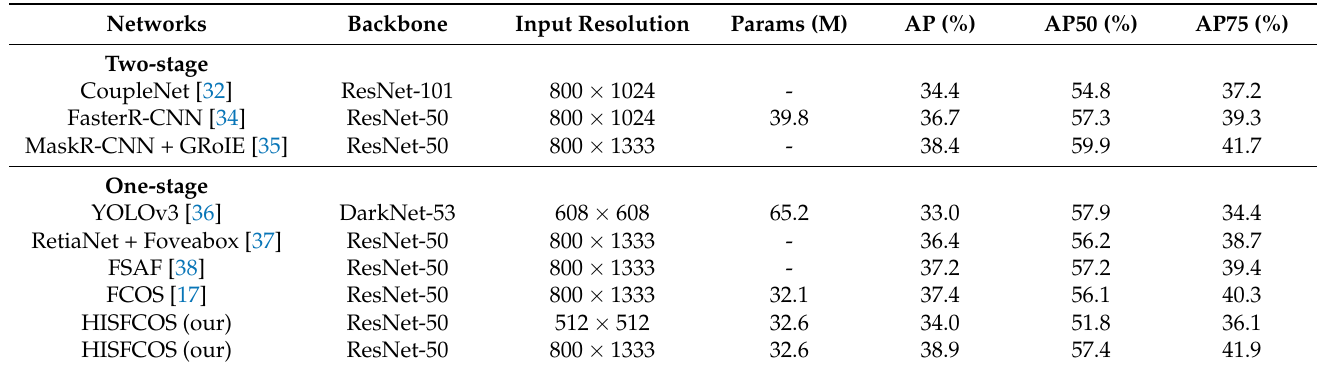
Table 3. Comparison of other networks using the MSCOCO 2017 minival dataset.